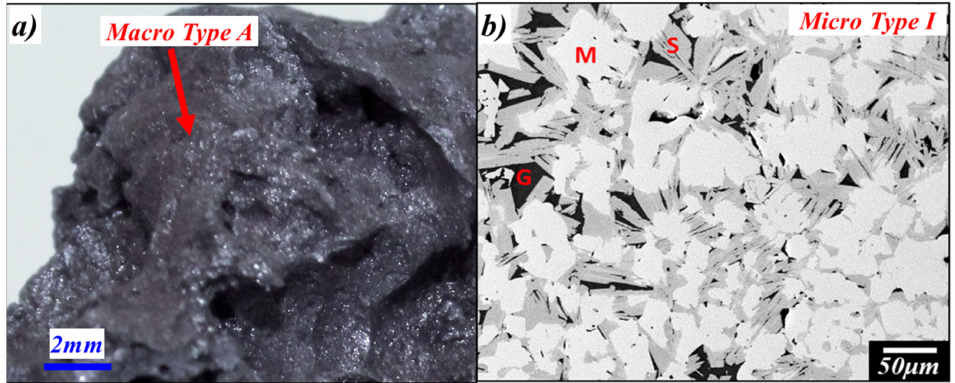
Figure 4. ( a ) Details of macro-features of type A (smooth/dull, molten, dense surface) taken by digital camera; ( b ) backscattered electron image of microstructure Macro-Type A, G = Glass; H = Hematite; M = Magnetite; S = SFCA solution; D = Dicalcium silicate (C 2 S); P = Pores.